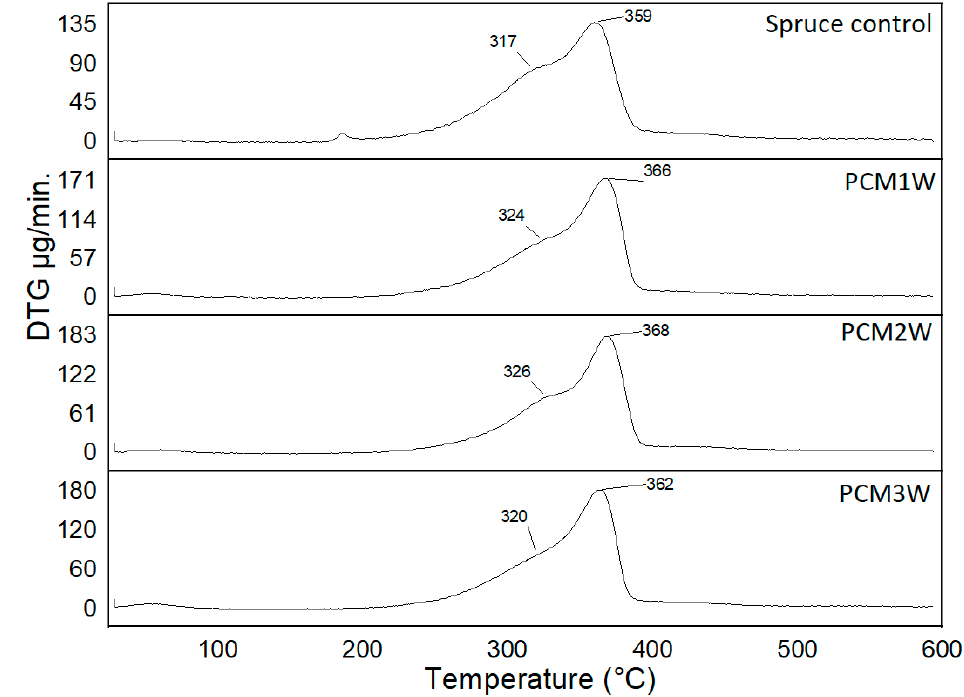
Figure 4. DTG curves of the PCMW1-3.